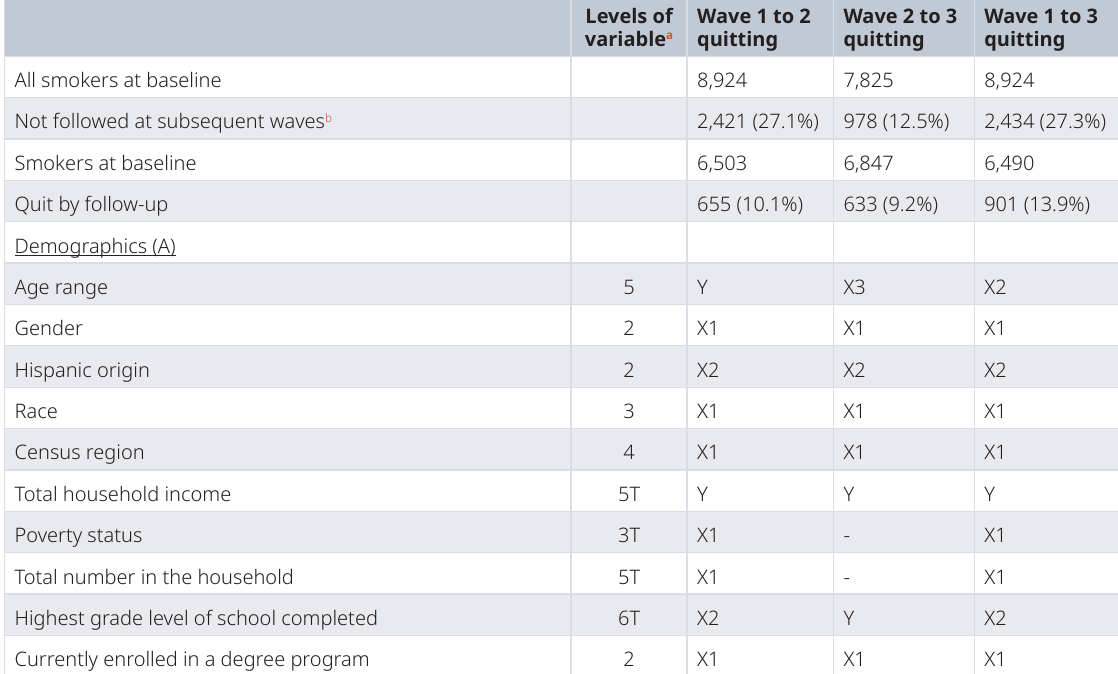
Table 1. Predictor variables included in the final regression analysis (Y) or excluded at steps 1, 2 or 3 (X1, X2,